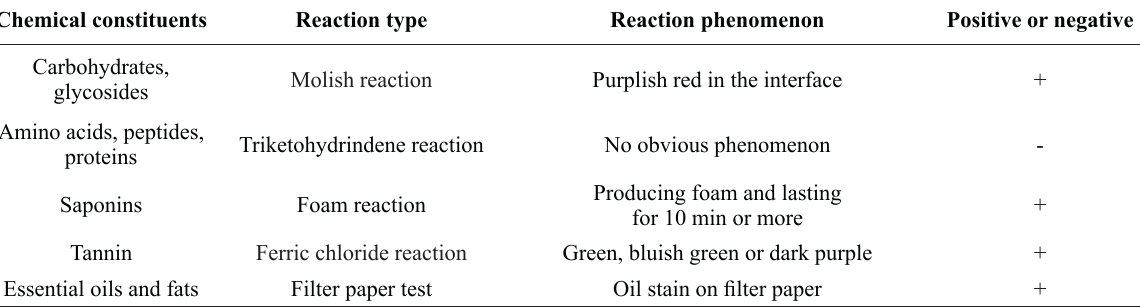
Preliminary phytochemical screening of water and petroleum ether extract from Desmodium caudatum .